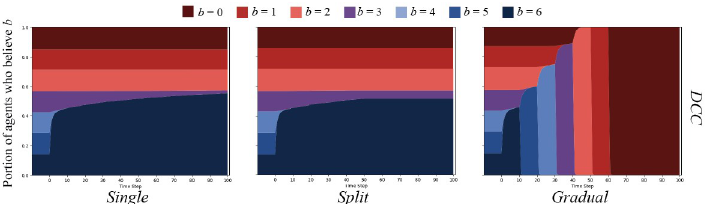
Fig 10. DCC results on homophilic MAG networks. DCC on homophilic MAG networks with N = 500, and Θ detailed in Eq (8). Graphs show the percent of agents who believe B with strength b over time.